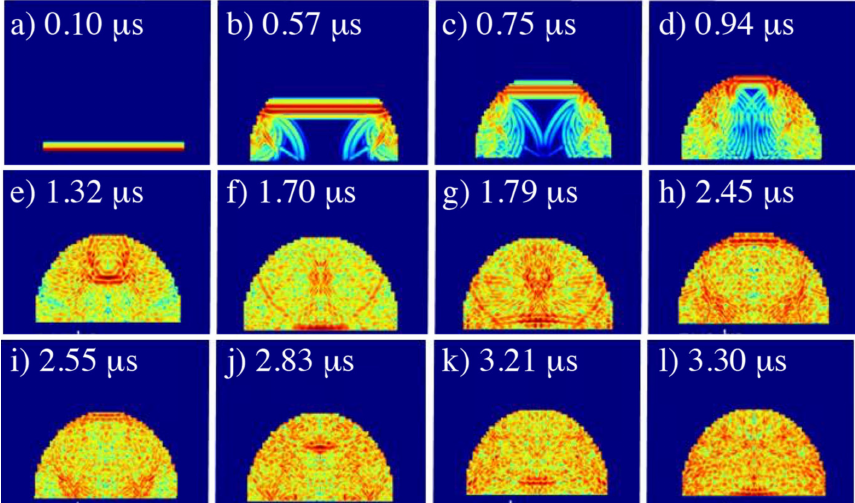
Figure 11. Simulated wave propagation in a 3 mm ice drop. The transducer that sends and receives the ultrasonic signal is located on the flat surface at the bottom of the panels. The amplitude of the ultrasonic waves is represented by the red and yellow colours. Darker red and yellow represent stronger waves (higher amplitudes), while blue colours correspond to low